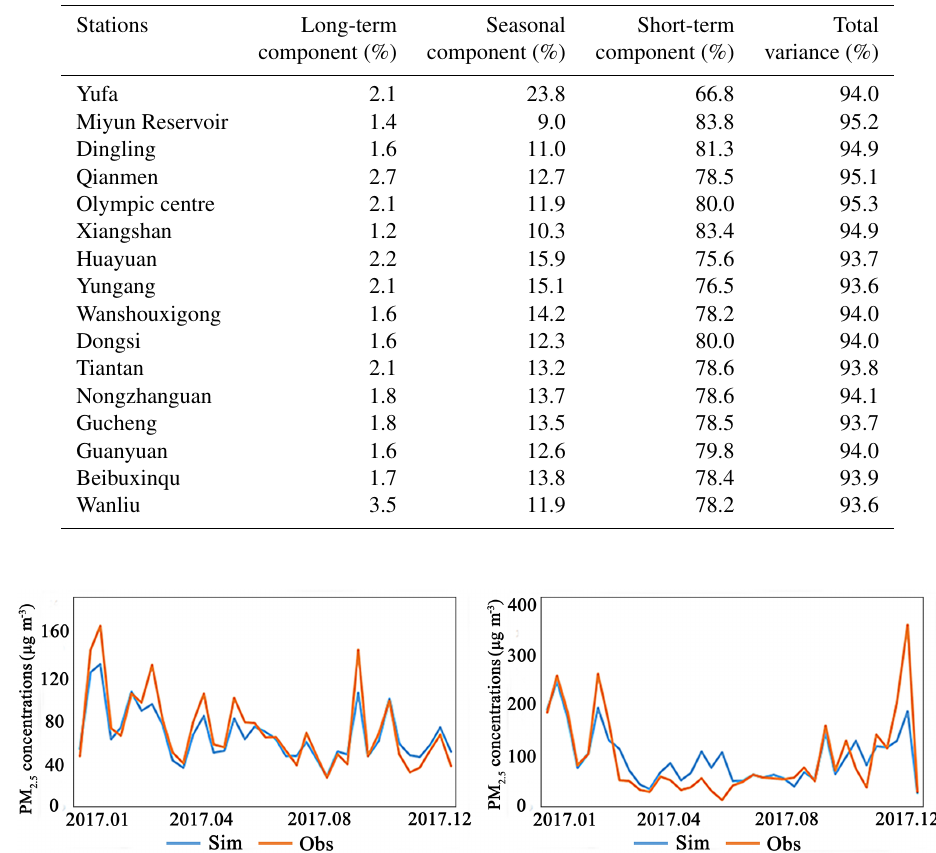
Table 4. The relative contribution of different components to the total variance of the original time series of PM 2 . 5 concentrations from 2013 to 2017 at different stations.